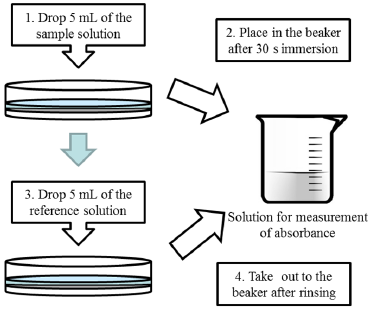
Figure 3. Measurement procedure of the amount of adsorbed onto the membrane.